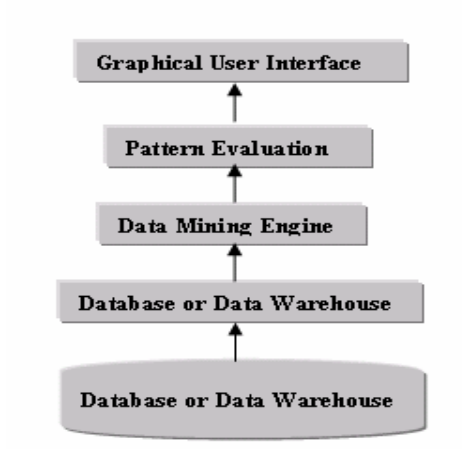
[Figure 2: Data mining Architecture]